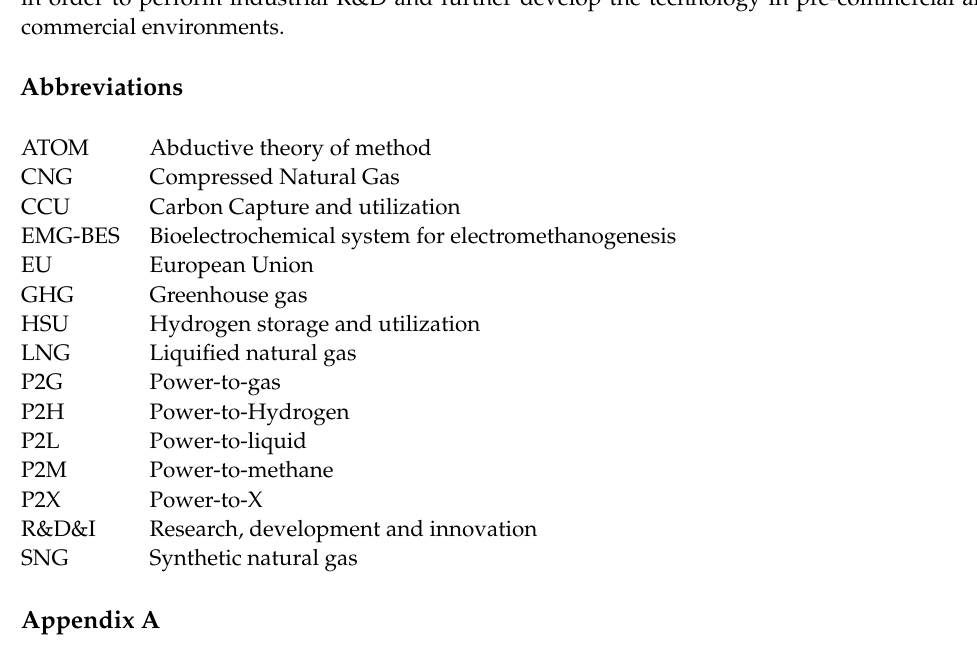
Table A1. Selected publications for quantitative text